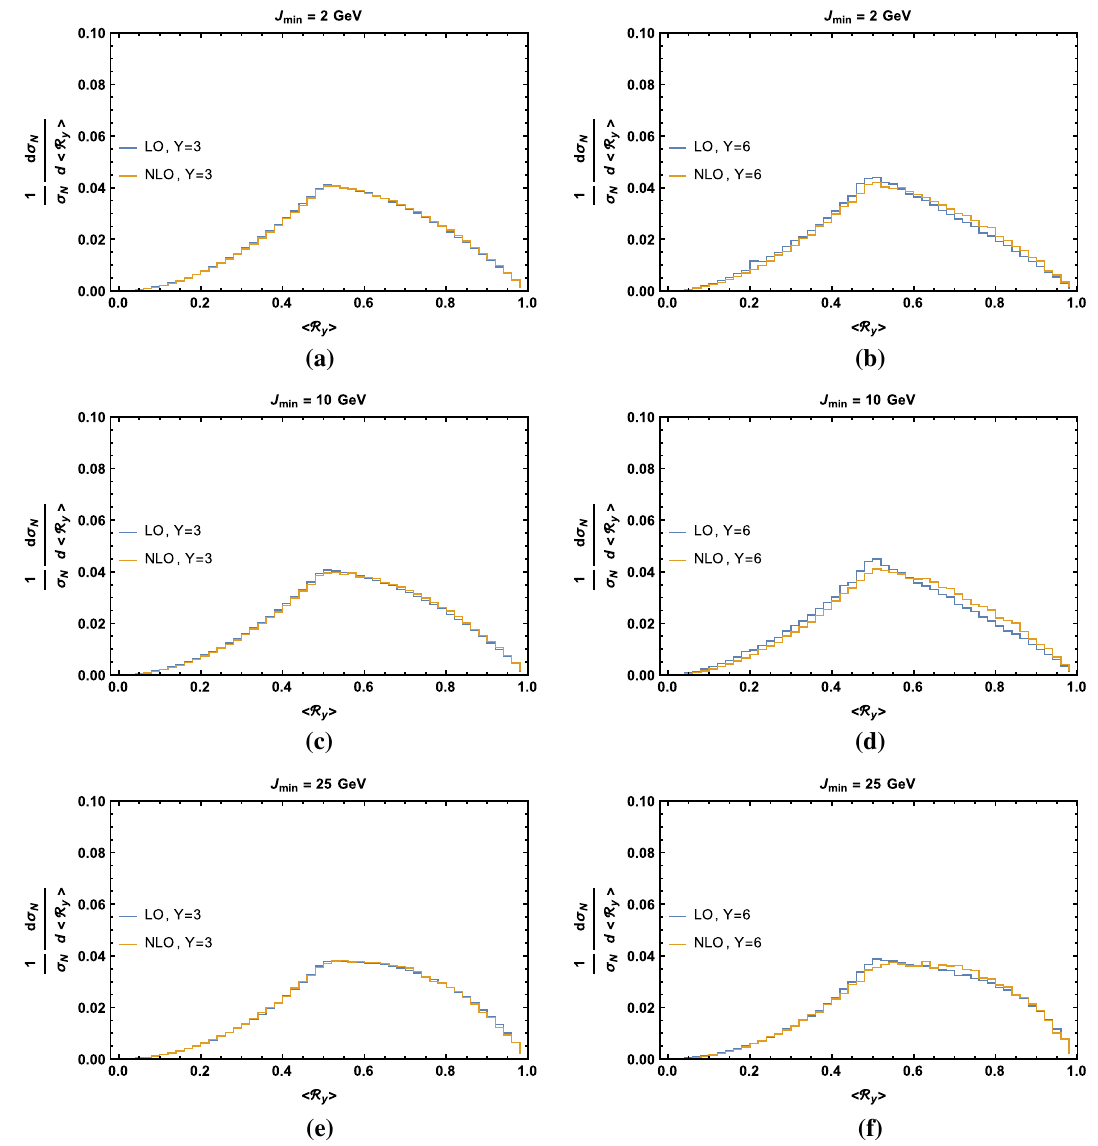
Fig. 8 Comparison of LO and NLO+DLs normalized (cid:10) R y (cid:11) distributions for multiplicity N = 3, rapidity differences Y = 3 (left) and Y = 6 (right) and J min = 2 (top), J min = 10 (middle), J min = 25